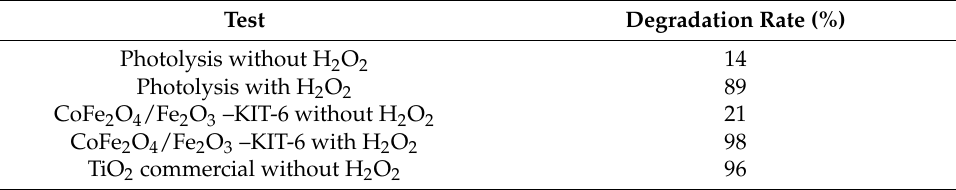
Table 3. Degradation rate results for the different solids for 1 h of reaction. Test